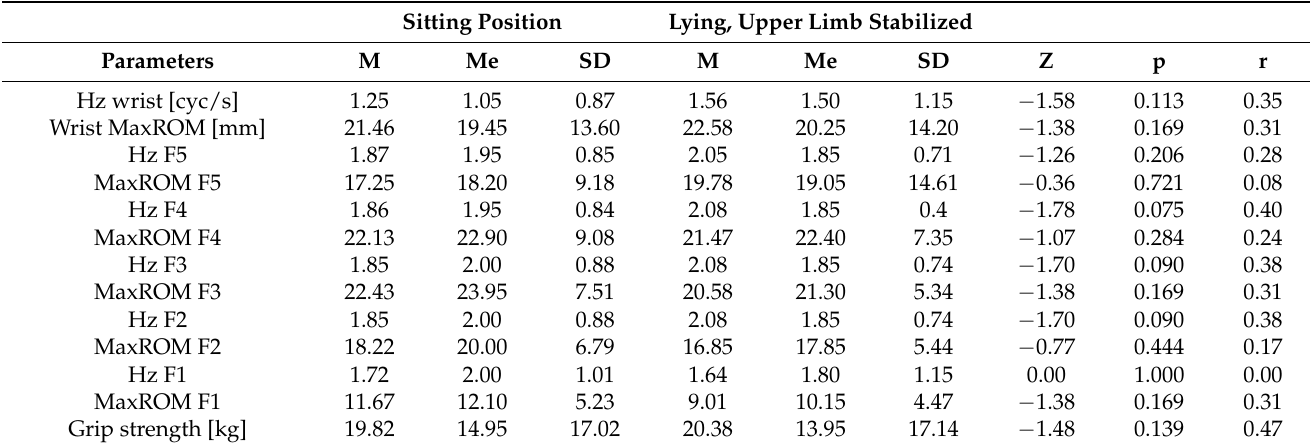
Table 4. Comparison of movement and strength parameters in sitting and lying positions with upper limb against the body in patients after a hemorrhagic stroke. Sitting Position Lying, Upper Limb Stabilized